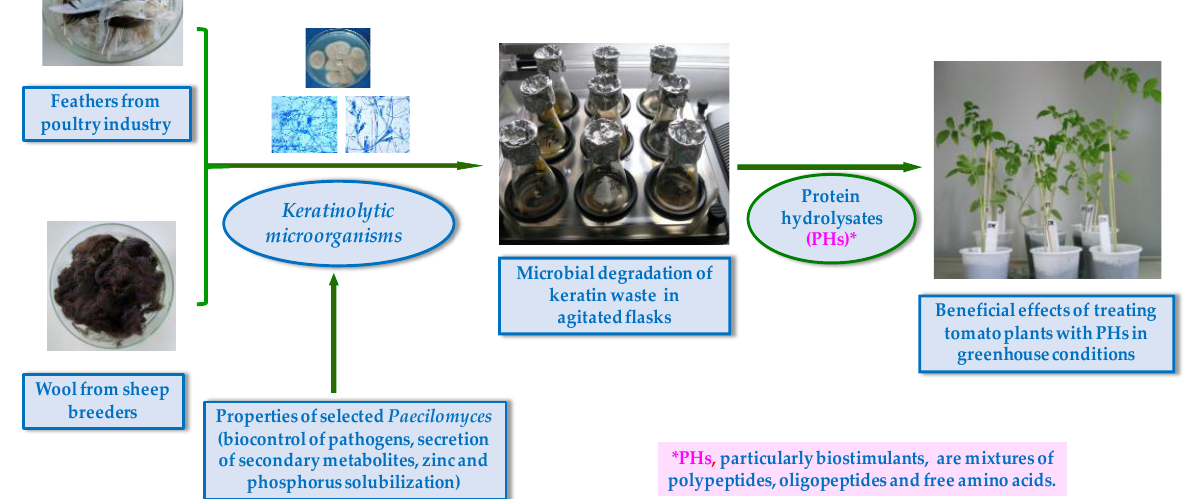
Figure 1. Schematic representation of plant treatments with protein hydrolyzates obtained from Paecilomyces lilacinus cultured on keratin wastes.